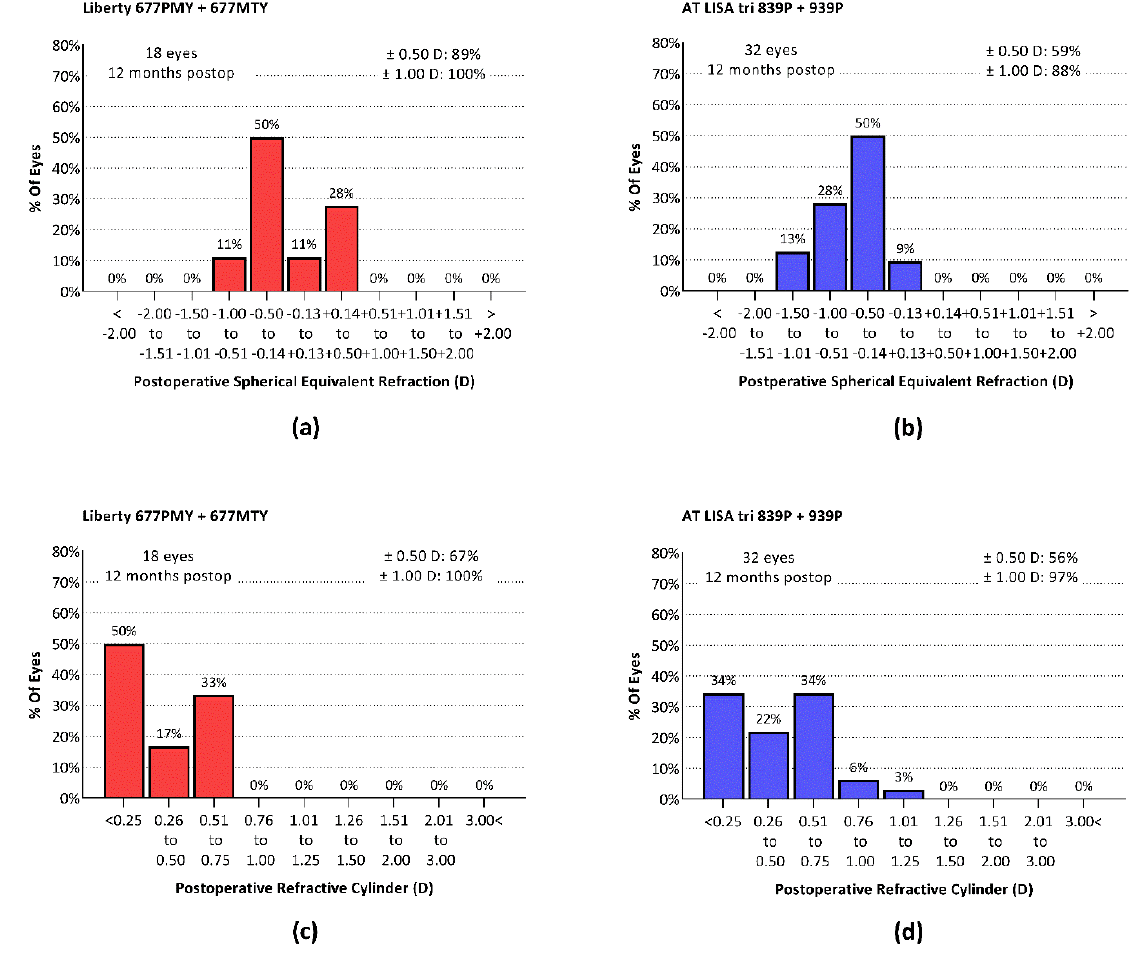
Figure 1. Postoperative spherical equivalent refractions and residual cylindrical refractions measured 12 months postoperatively. ( a ) Postoperative SEQ Liberty group; ( b ) postoperative SEQ AT LISA tri group; ( c ) residual astigmatism Liberty group; ( d ) residual astigmatism AT LISA tri group.